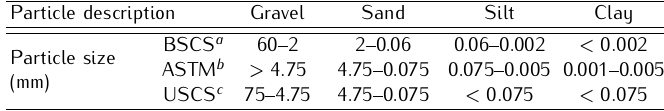
Table 1. Soil definition with respect to particle size